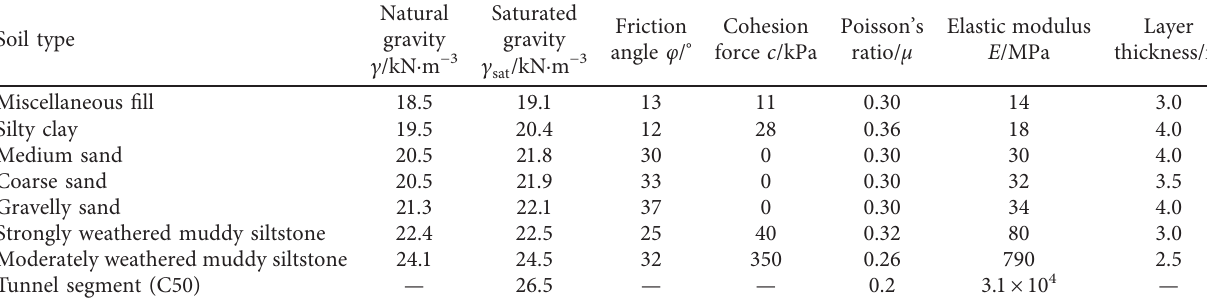
Table 3: Physical and mechanical parameters of soil layers.